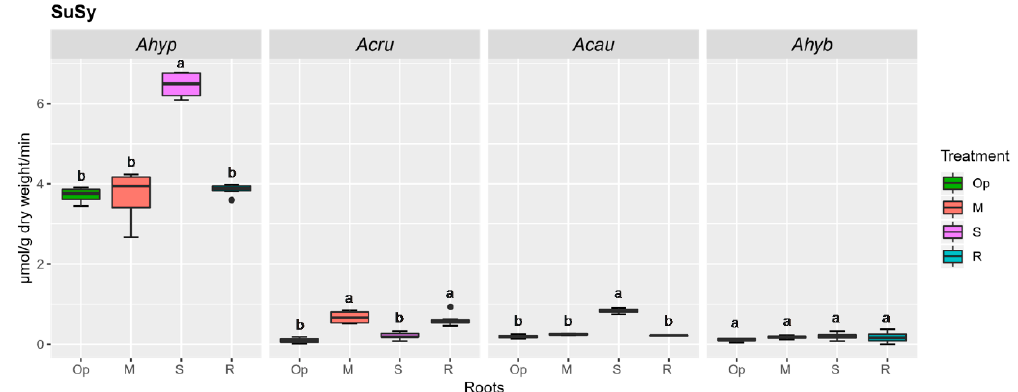
Figure 5. Sucrose synthase (SuSy) activity in roots of amaranth plants subjected to water-deficit stress. SuSy activity in roots of Amaranthus hypochondriacus (Ahypo), A. cruentus (Acru), A. caudatus (Acau),